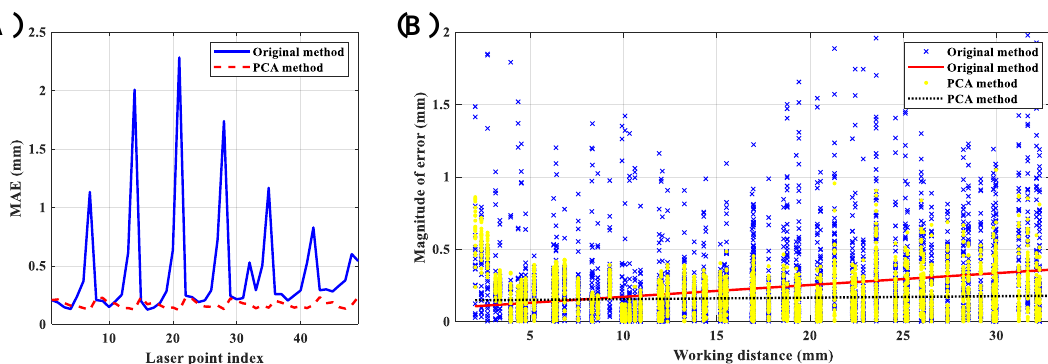
Figure 8. Performance of estimating the working distance: ( A ) measurement accuracy of different laser points, ( B ) effect of working distance.